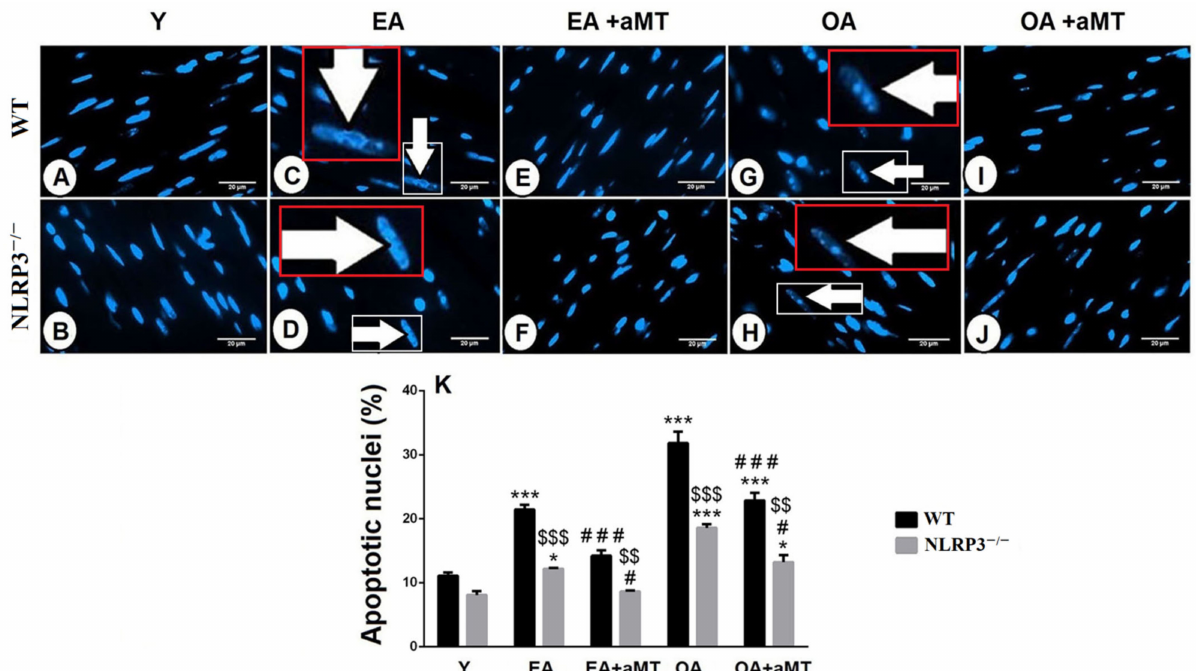
Figure 7. Impact of NLRP3 deletion and melatonin therapy on age-dependent cardiac apoptosis. ( A , B ) Hoechst fluorescent analysis of the nuclear apoptosis in the LV of the Y WT and NLRP3 − / − mice, respectively showing normal nuclear appearance. ( C , D ) Analysis of the nuclear apoptosis in the LV of the EA WT and NLRP3 − / − mice, respectively revealing that aging induced nuclear apoptosis and fragmentation (arrows). Higher magnifications of the white boxed areas in the red insets. ( E , F ) Analysis of the nuclear apoptosis in the LV of the EA WT and NLRP3 − / − mice, respectively after melatonin therapy clarifying the protective effect of melatonin on reducing cardiac apoptosis. ( G , H ) Analysis of the nuclear apoptosis in the LV of the OA WT and NLRP3 − / − mice, respectively exhibiting more detectable nuclear apoptosis. Higher magnifications of the white boxed areas in the red insets. ( I , J ) Analysis of the nuclear apoptosis in the LV of the OA WT and NLRP3 − / − mice, respectively after melatonin treatment confirming the beneficial effect of melatonin against age-related cardiac apoptosis. (K) Morphometriacal analysis of apoptotic nuclei of cardiomyocytes during aging revealing that cardiac apoptosis was more considerable in cardiac myocytes of WT mice than in those of NLRP3 − / − one. Bar “white line” = 20 µ m. * p < 0.05 and *** p < 0.001 vs. Y; # p < 0.05 and ### p < 0.001 vs. aged group without melatonin; $$ p < 0.01 and $$$ p < 0.001 vs. WT